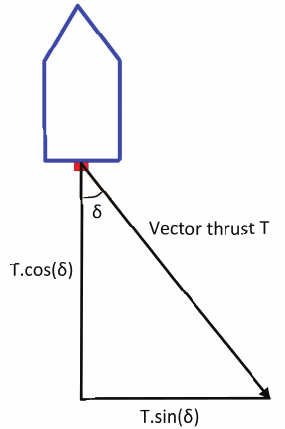
Figure 6. A schematic diagram of the vector thrust